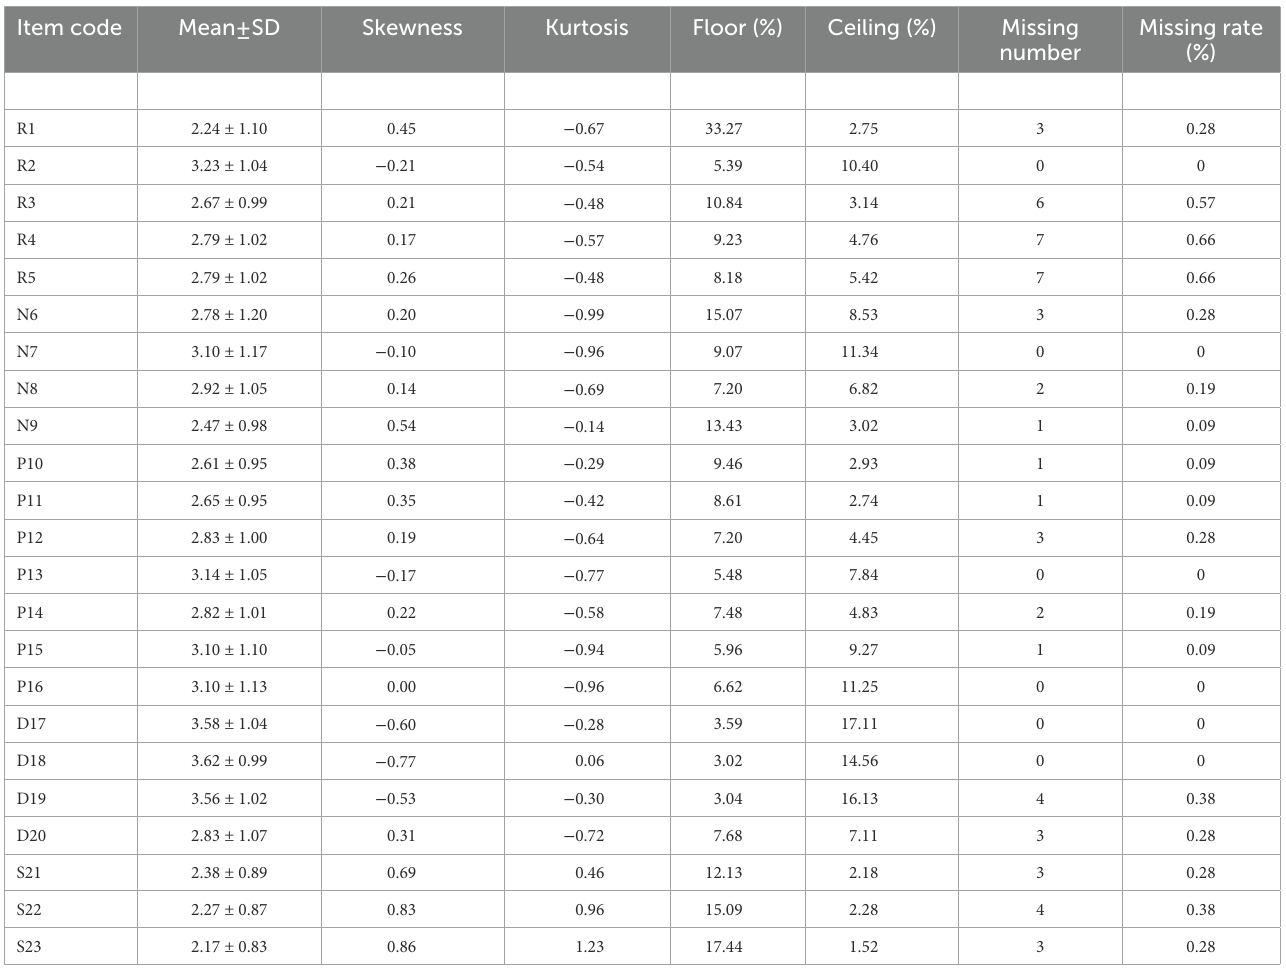
TABLE 3 Descriptive statistics of hepatitis B virus infection-related stigma scale (HBVISS) items ( n = 1,058). Item code